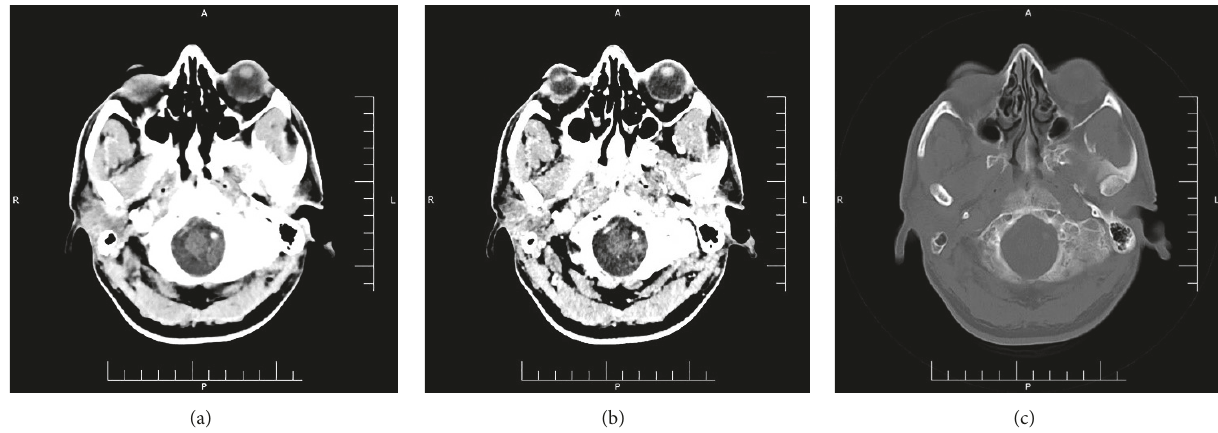
Figure 1: (a) Tri-dimensional CT scan reveals increasing of the thickness of right maxillary sinus soft tissue. (b) Massive destruction of right maxillary body. (c) Right maxillary sinus opacity with destruction of sinus